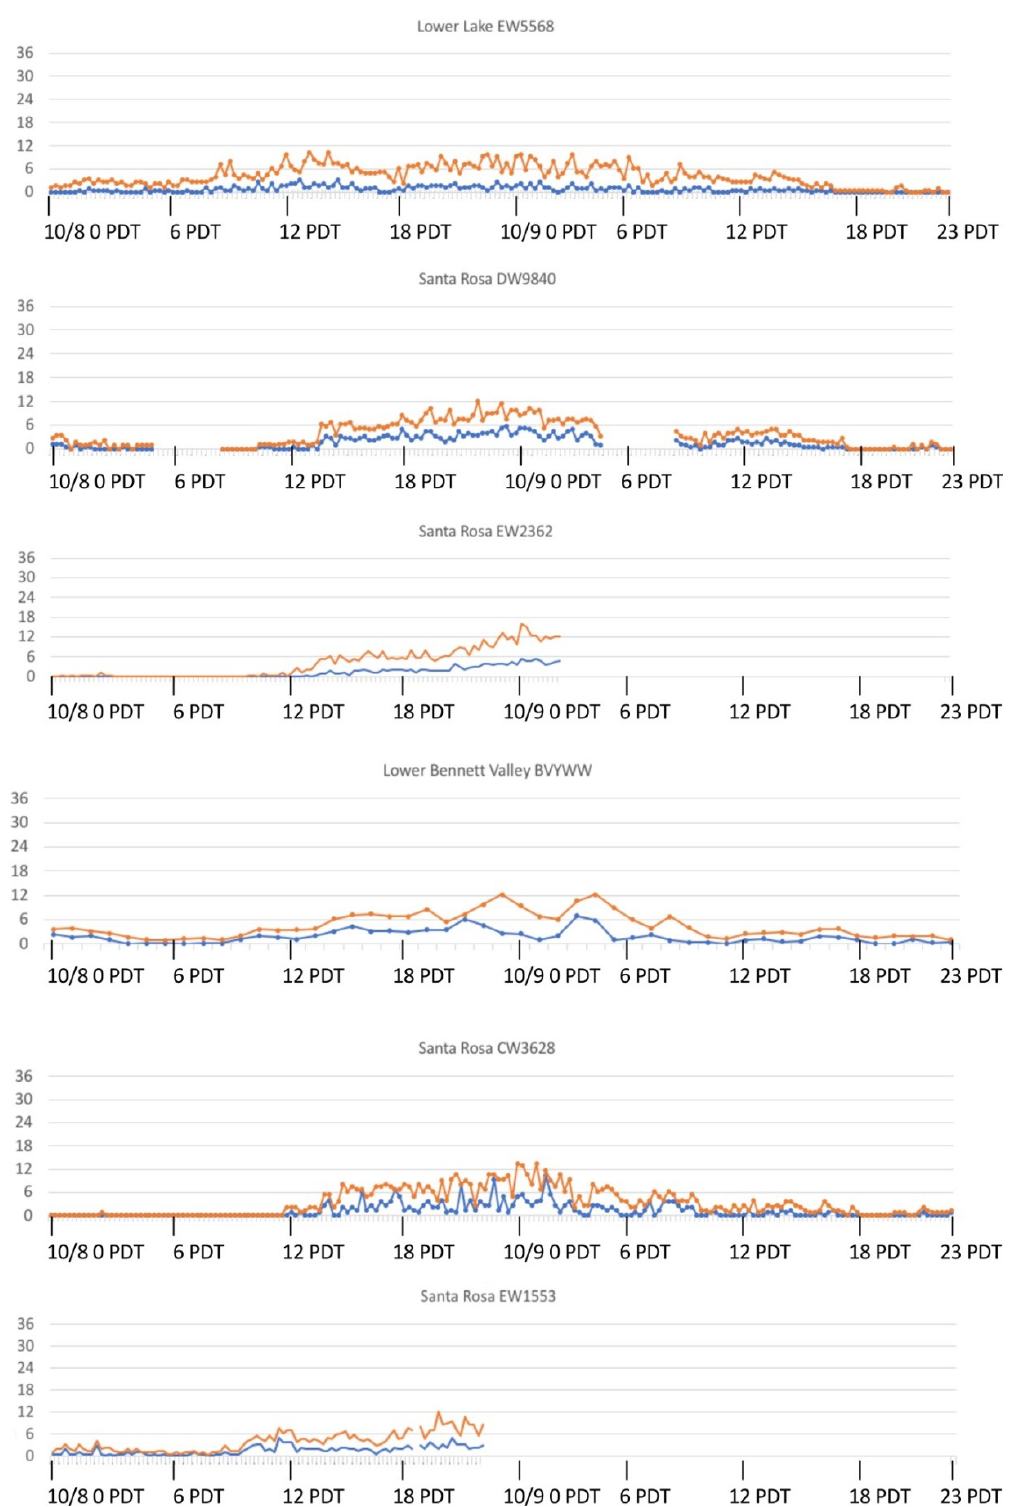
Figure 5. Wind speed (blue) and wind gust (orange) data (in m/s) from surface stations located in Figure 3 that recorded weaker wind speeds.